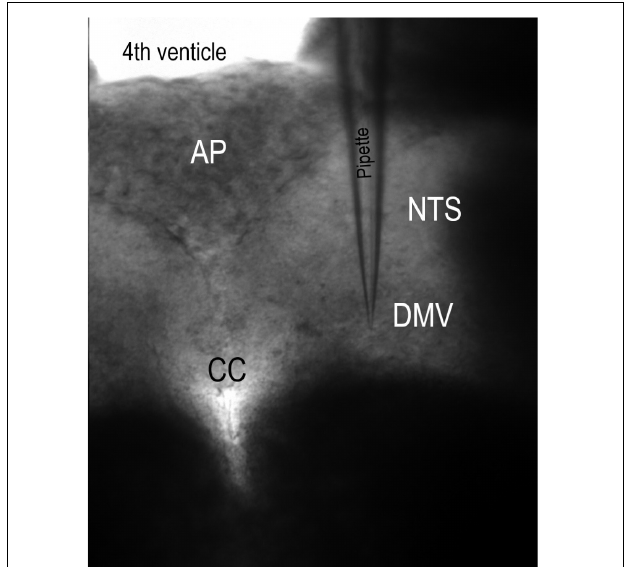
FIGURE 1 | Coronal slice of the brainstem. This 10 × magnification micrograph of the rat brainstem slice was retained in a perfusion chamber with polyethylene strands. Pipette, recording electrode. AP, area postrema. CC, central canal. DMV, dorsal motor nucleus of the vagus. NTS, nucleus tractus